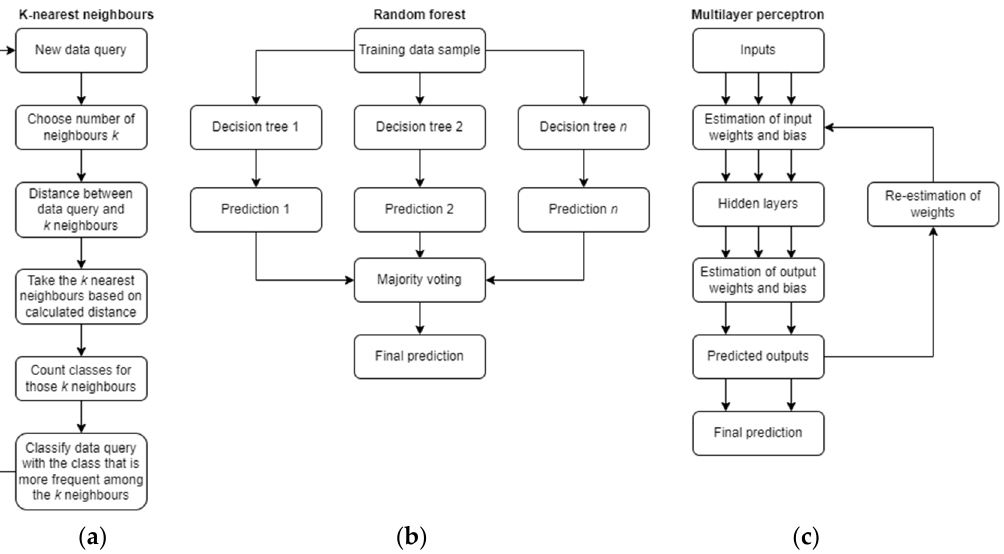
forest, ( c ): multilayer Figure 3. Schematics of selected classification algorithms. ( a ): K-nearest neighbors, ( b ): random for- est, ( c ): multilayer perceptron.